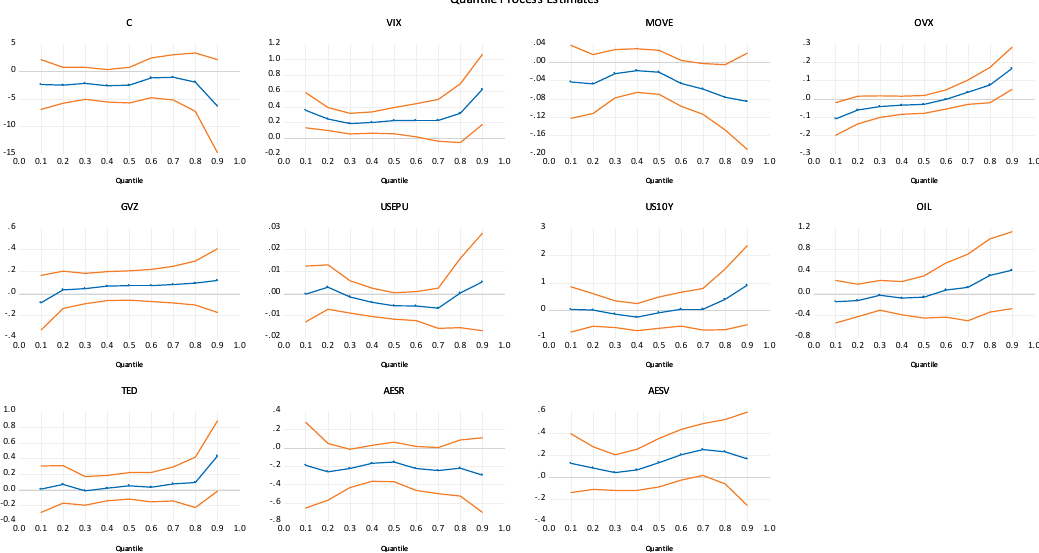
Figure 5. Quantile regression coefficient estimates in the case of UAE, with 95% confidence intervals. Vertical axes show the coefficient estimates of the explanatory variable over the UAE CDS spreads distribution. Horizontal axes show the quantiles of the dependent variable.